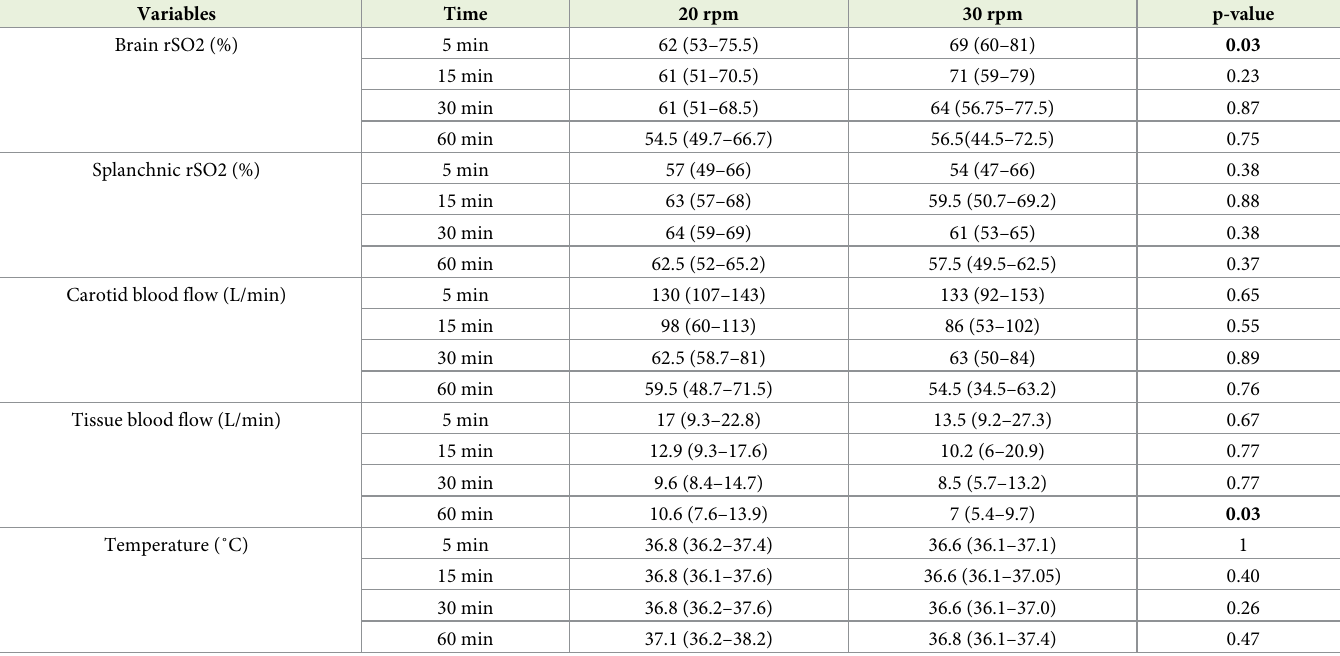
Table 3. Perfusion parameters after ROSC.